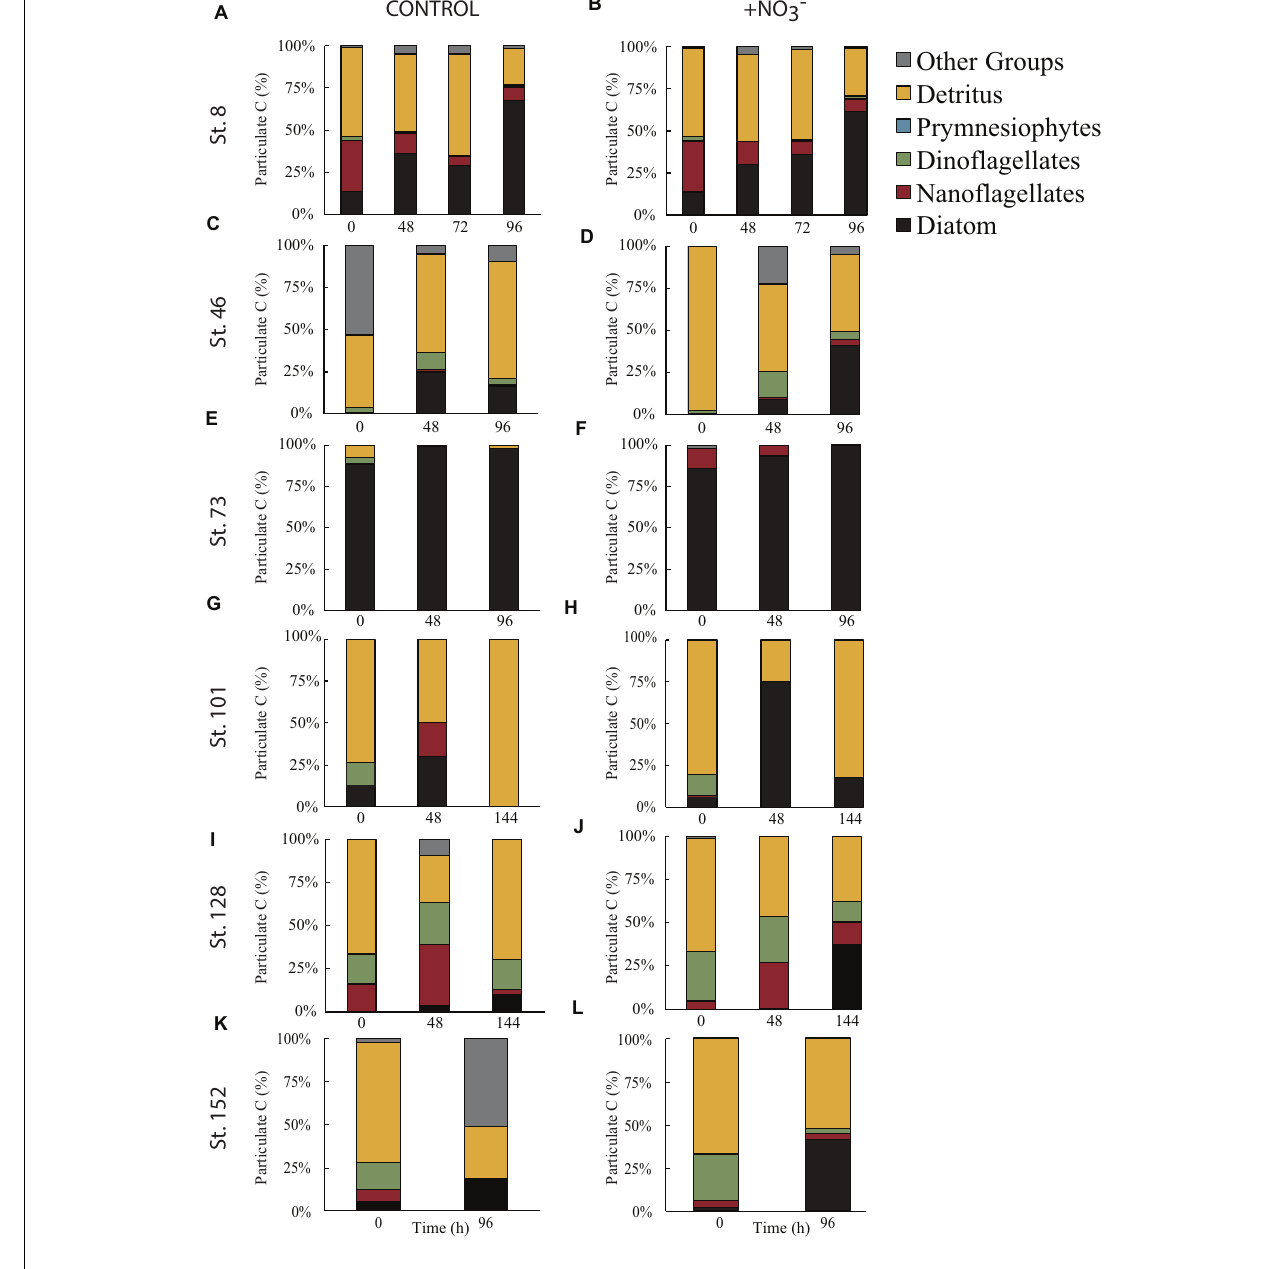
mid-shelf sites and the Bering Strait site, the + NO 3 − treatment increased 12–23 and 5%,